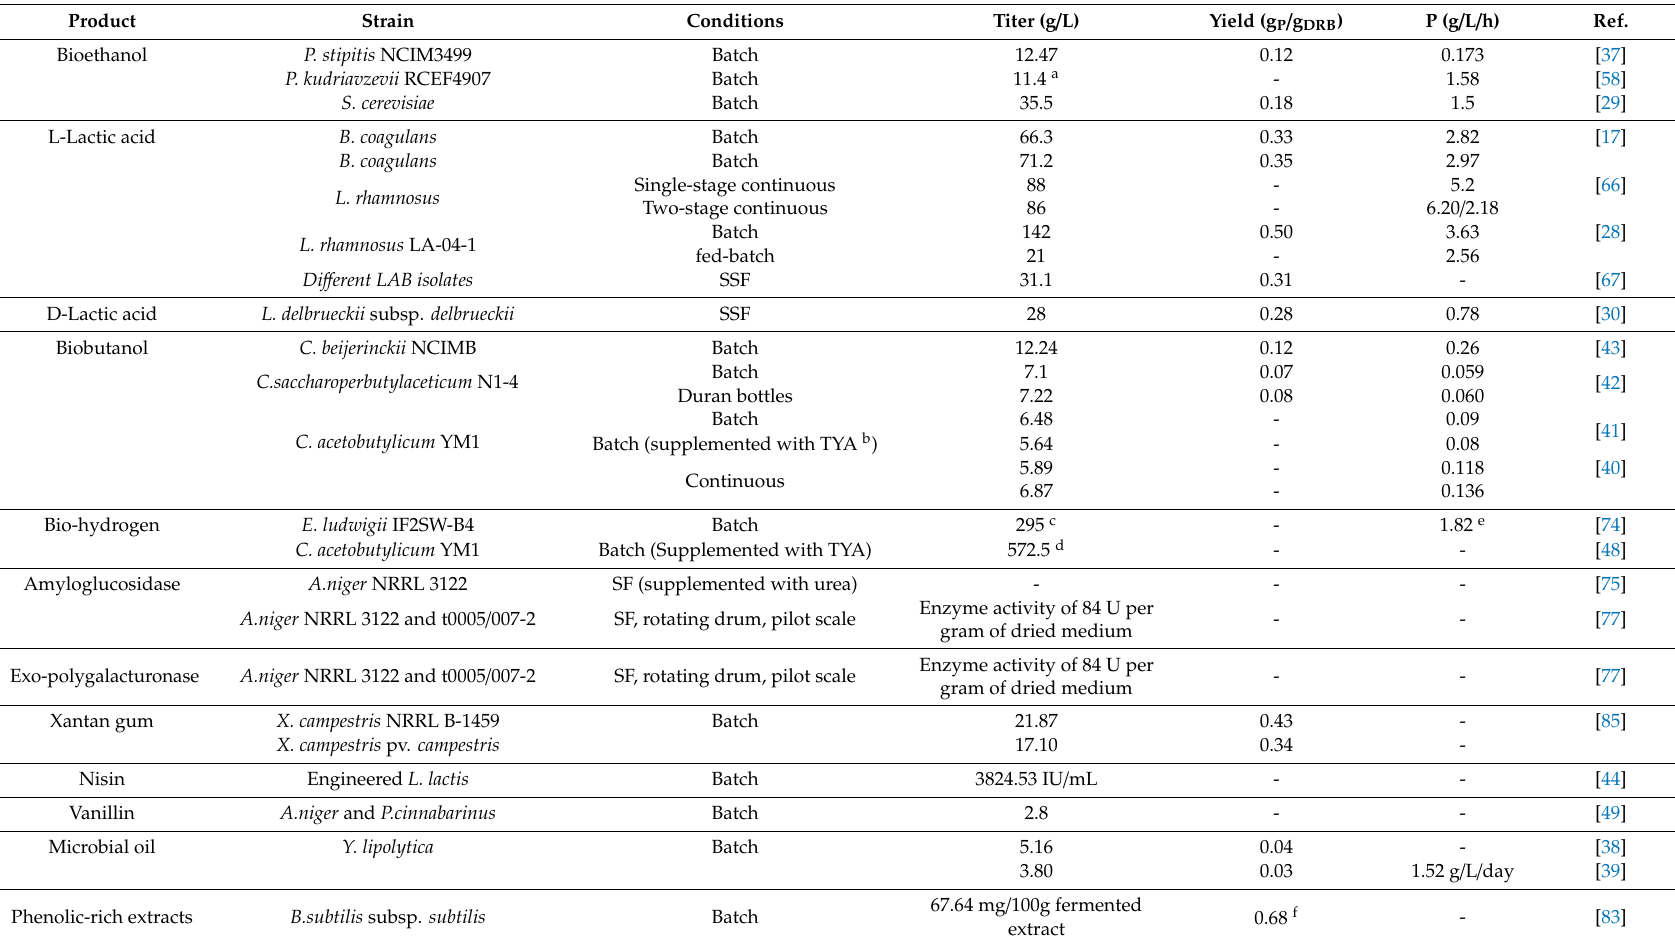
Table 3. Production of various biotechnological products from